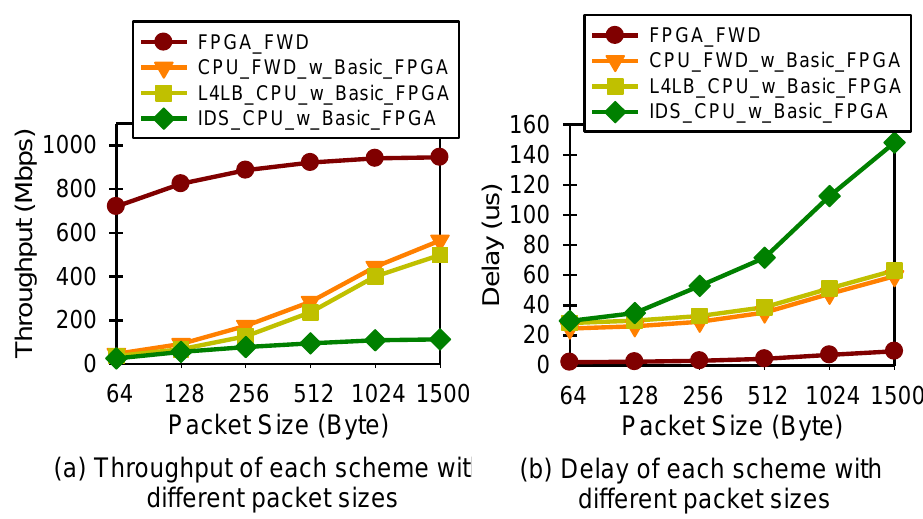
Figure 10. Throughput and latency evaluation at different packet sizes in each scheme.